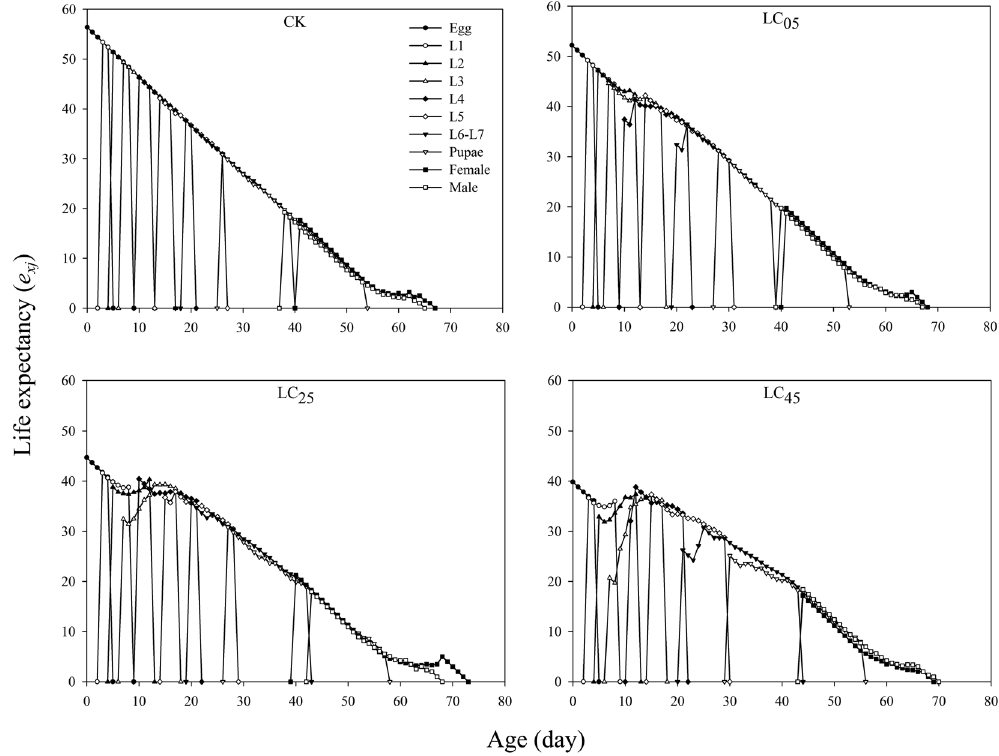
Figure 4. Life expectancy ( e xj ) of A. ipsilon after exposure to low-lethal concentrations of